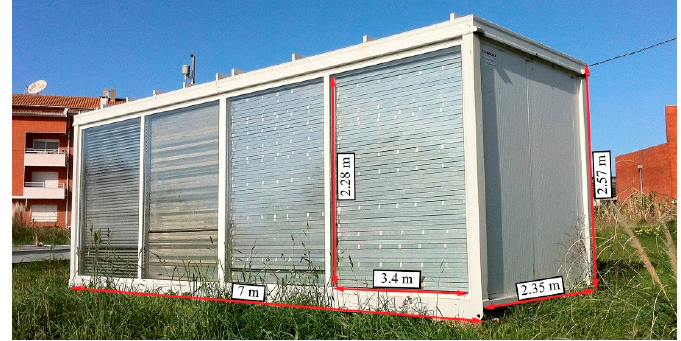
Figure 15. Test rooms’ outside view including shutter windows [50–52].